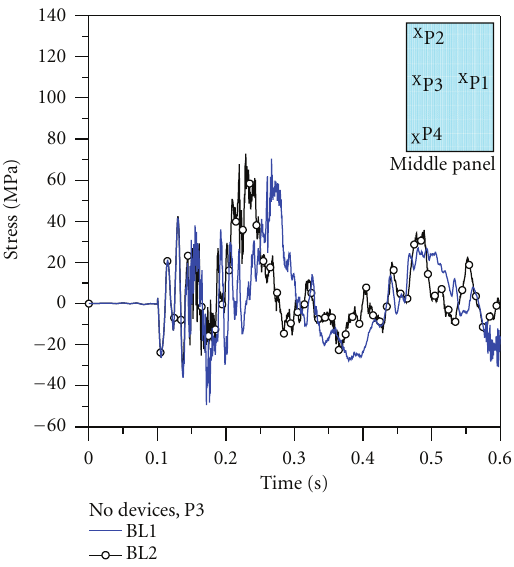
Figure 7: Comparison of maximum tensile stresses at location P3, as a function of time (ABAQUS). No devices. M01 FE-model, BL1 and BL2.